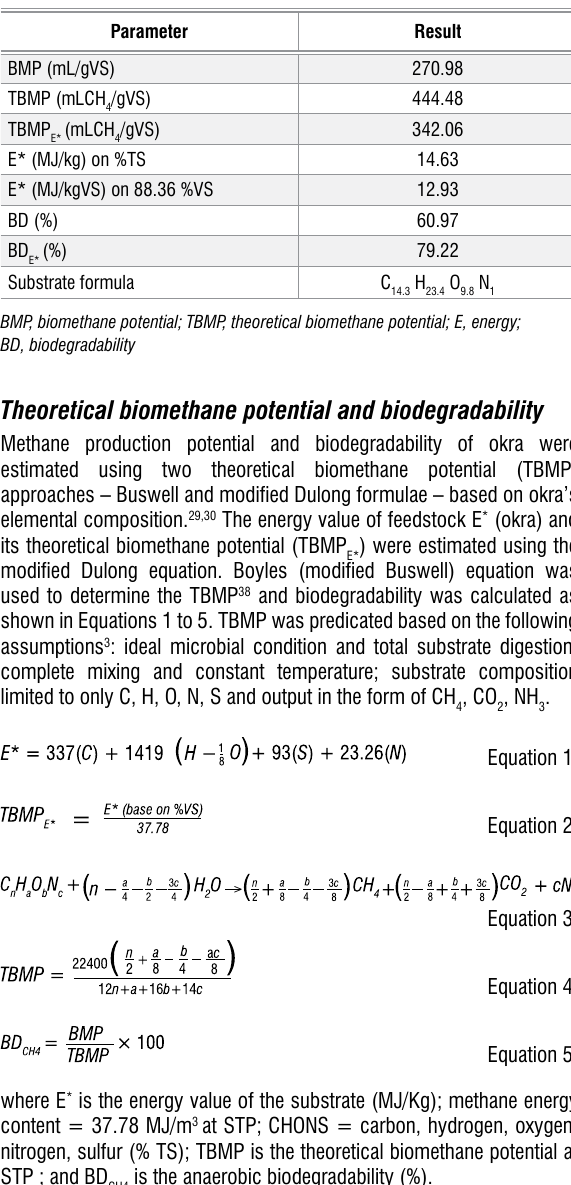
Figure 2: Cumulative biogas production based on experimental and kinetic modelling Summary of key energy production parameters